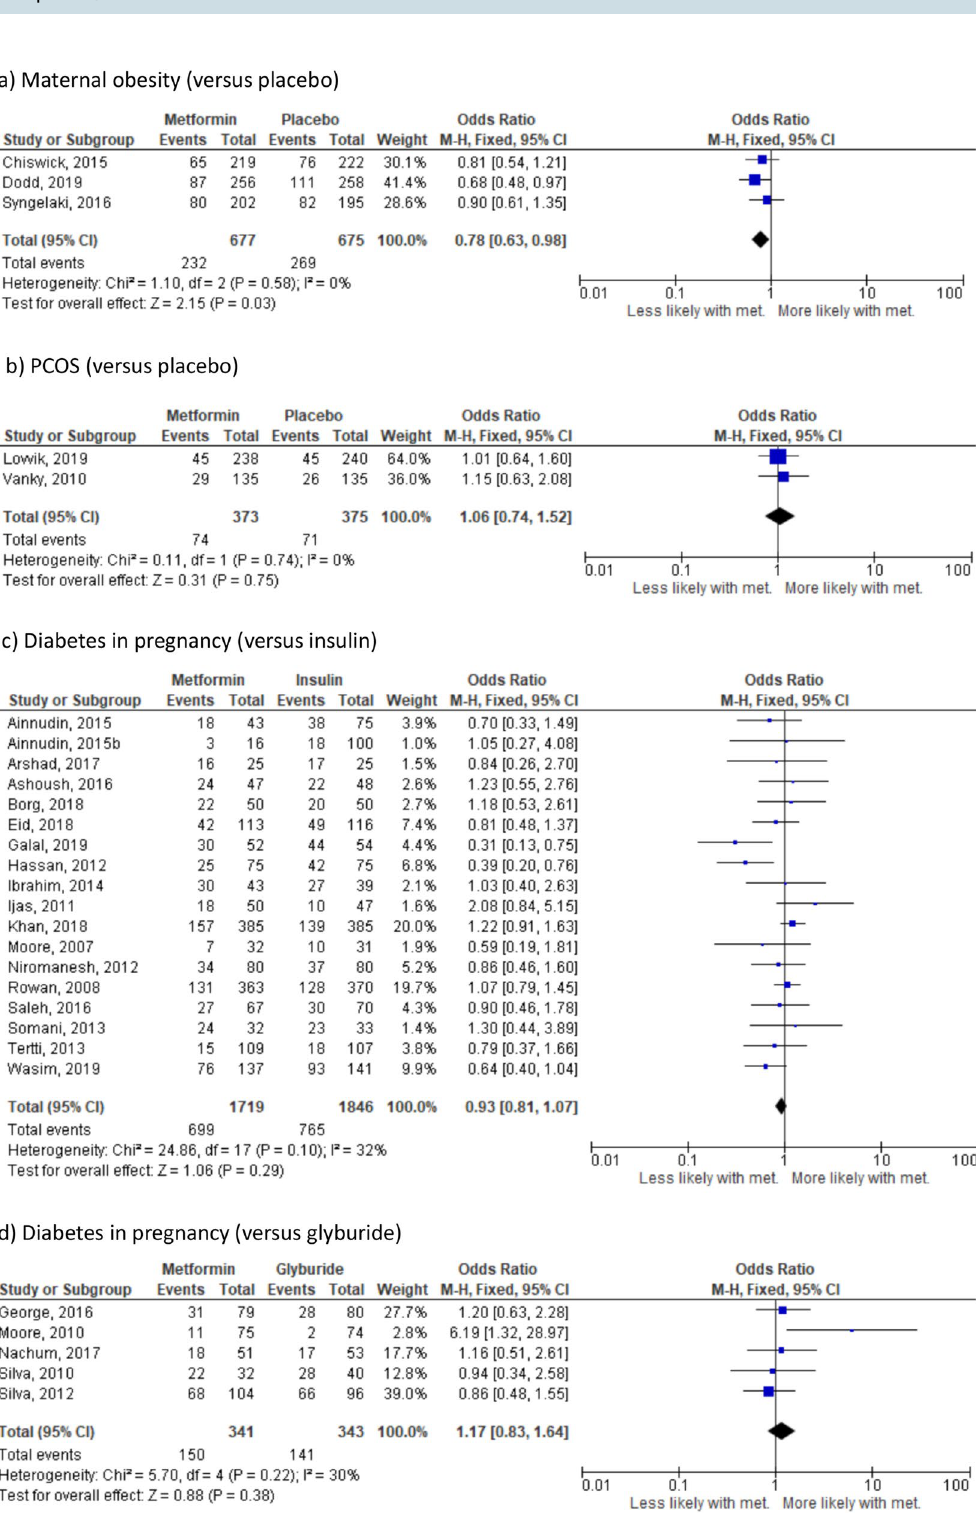
Figure 6. Effect of metformin randomisation upon caesarean section (all indications). ( a ) All cause, (based on 29 studies including 6122 pregnancies), ( b ) emergency (based on 7 studies including 1772 pregnancies) and ( c ) elective (based on 5 studies including 1552 pregnancies). Odds ratio (95% CI). Random-effects model for ( a ) and ( b ). Fixed-effects model for ( c